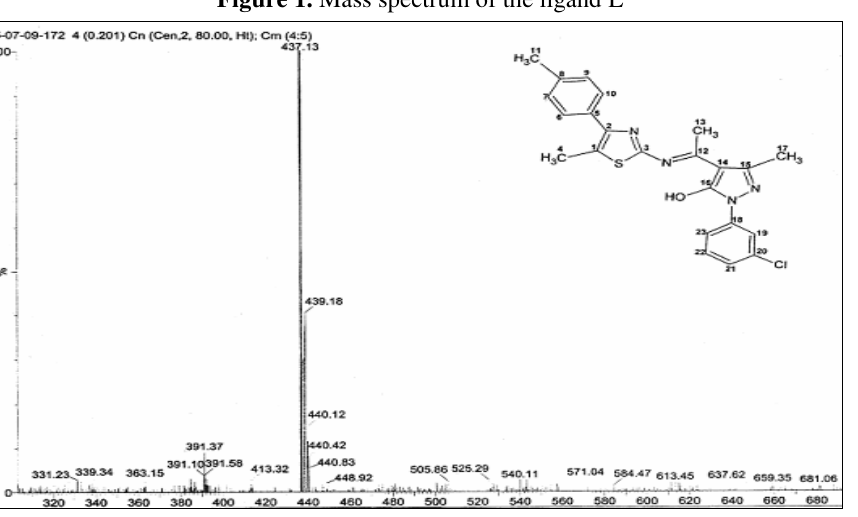
Figure 2. Mass spectrum of the ligand L